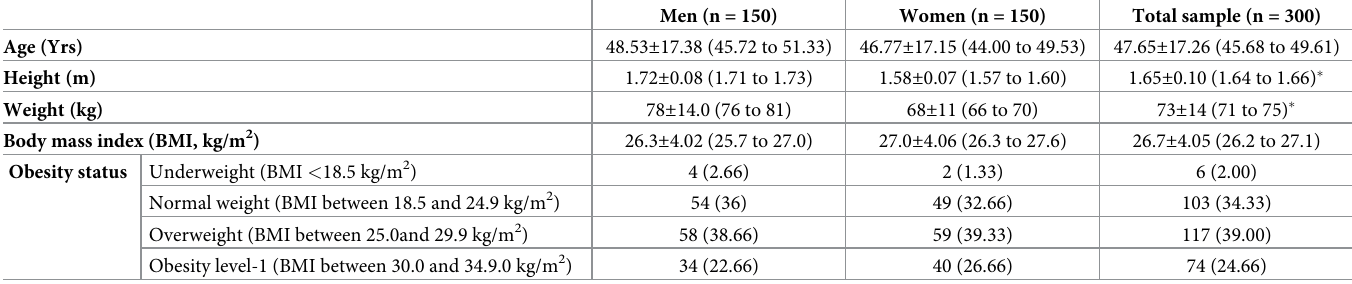
Table 1. Anthropometric data of the healthy non-smoker adults aged 18–85 years.